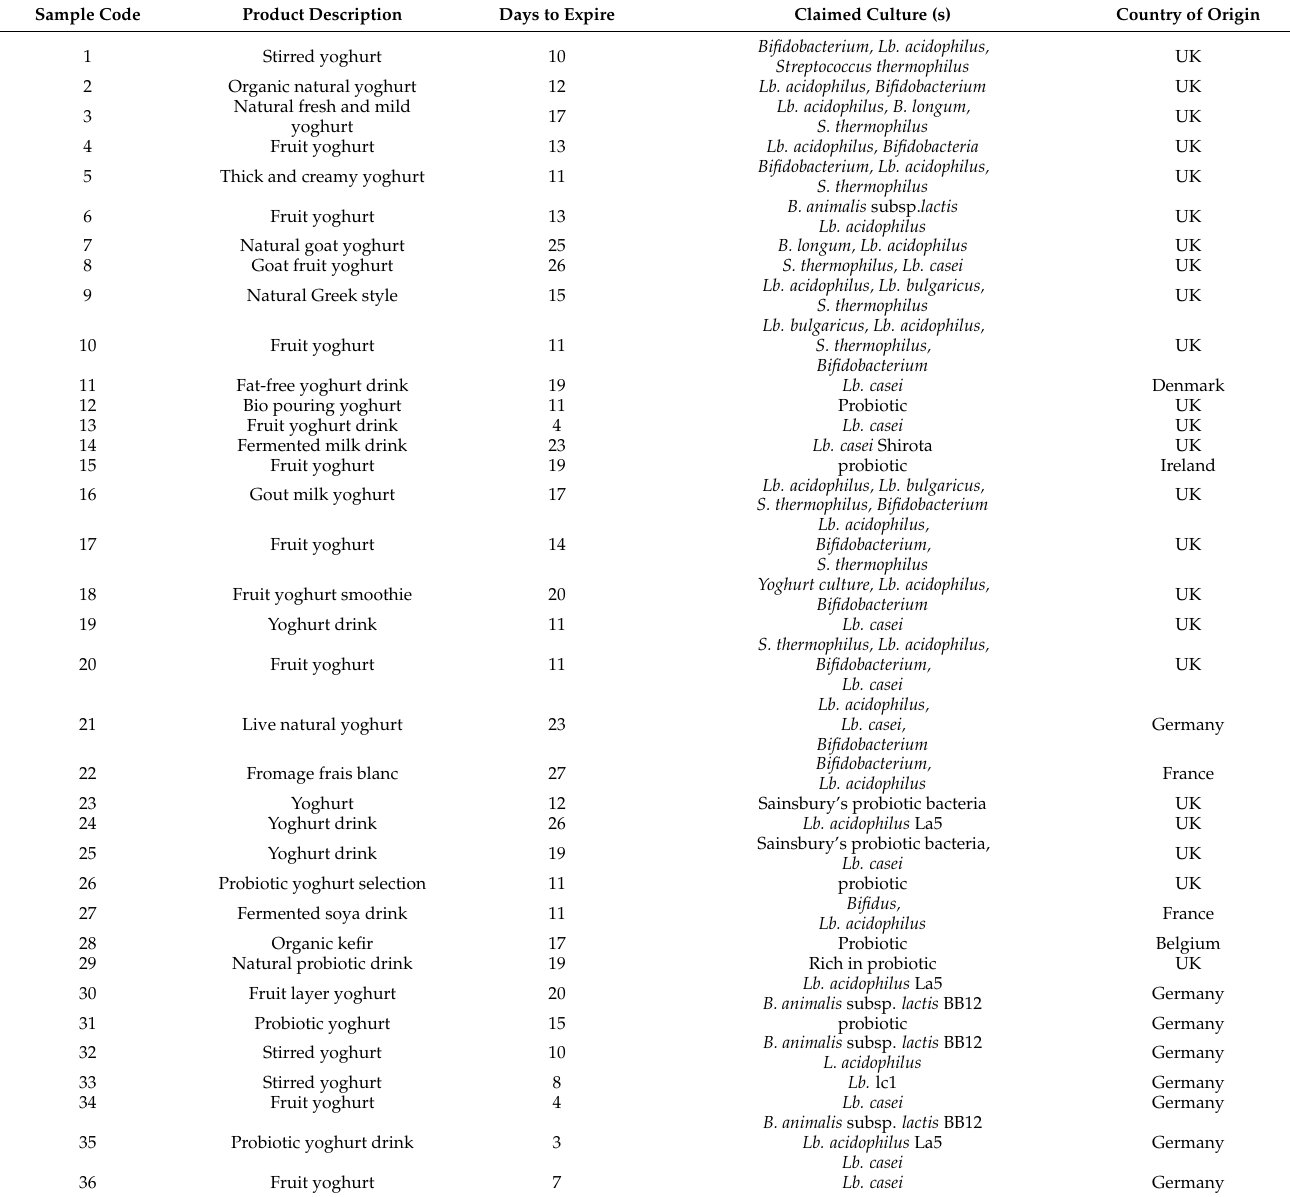
Table 1. Details of tested probiotic